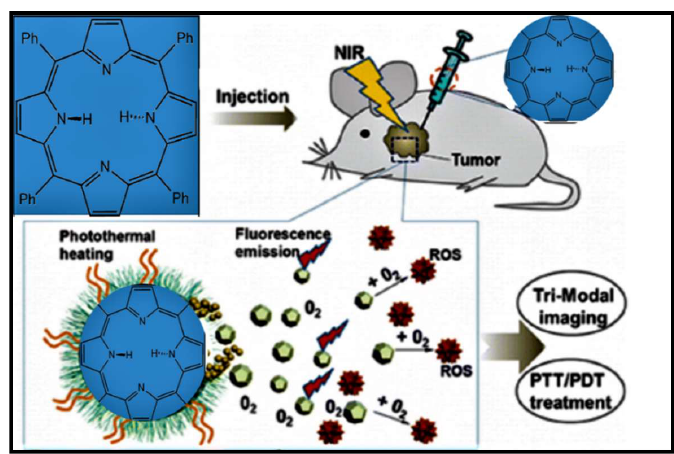
Figure 7. Photo-thermal therapy (PTT) and PDT treatment using singlet oxygen producing porphyrin [51].